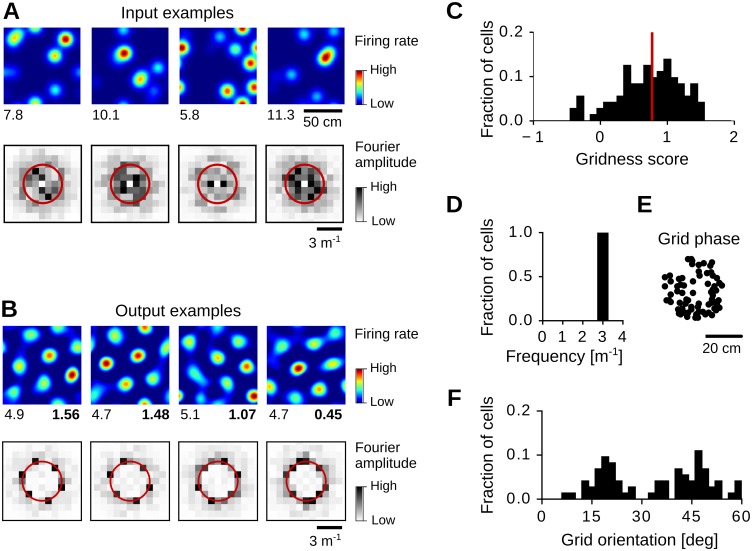
Grid-pattern formation with spatially-irregular inputs.(A) Four examples of irregular input firing-rate maps (top row) and the corresponding Fourier spectra (bottom row). The maximal firing rate (spikes/s) is reported at the bottom-left corner. The red circles indicate the spatial frequency kmax = 3 m−1. (B) Four examples of output firing-rate maps (top row) and the corresponding Fourier spectra (bottom row). The gridness score is reported at the bottom-right corner. Output firing-rate maps were estimated from the average weight dynamics in Eq 16 (t = 106 s) for four different realizations of the spatial inputs. (C-F) Distribution of gridness scores (C), grid spatial frequencies (D), grid spatial phases (E), and grid orientations (F) for 100 random realizations of the spatial inputs. The red vertical line in C indicates the mean score (0.77). See Sec Numerical simulations for further details and parameter values.